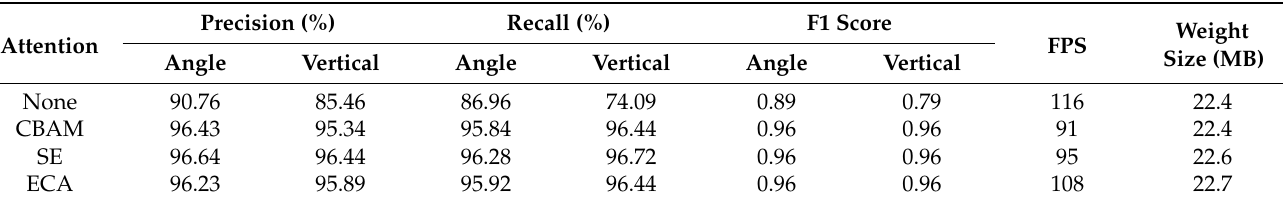
Table 3. Comparing network detection results.